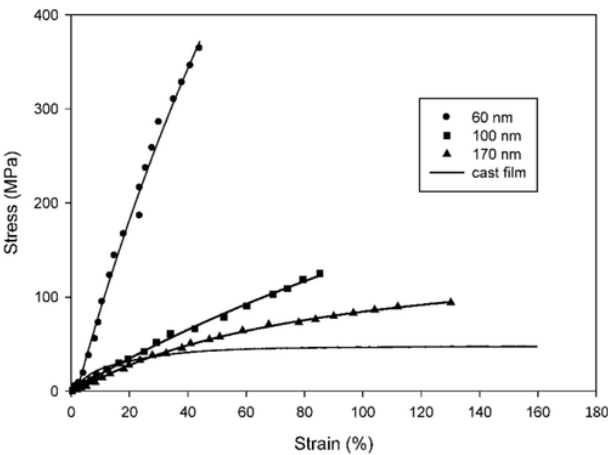
Figure 1. A typical plot of stress–strain relationship for nylon-6 nanofibers of different diameters, with the reference being the cast film. Reproduced from [26] with the permission of Elsevier.